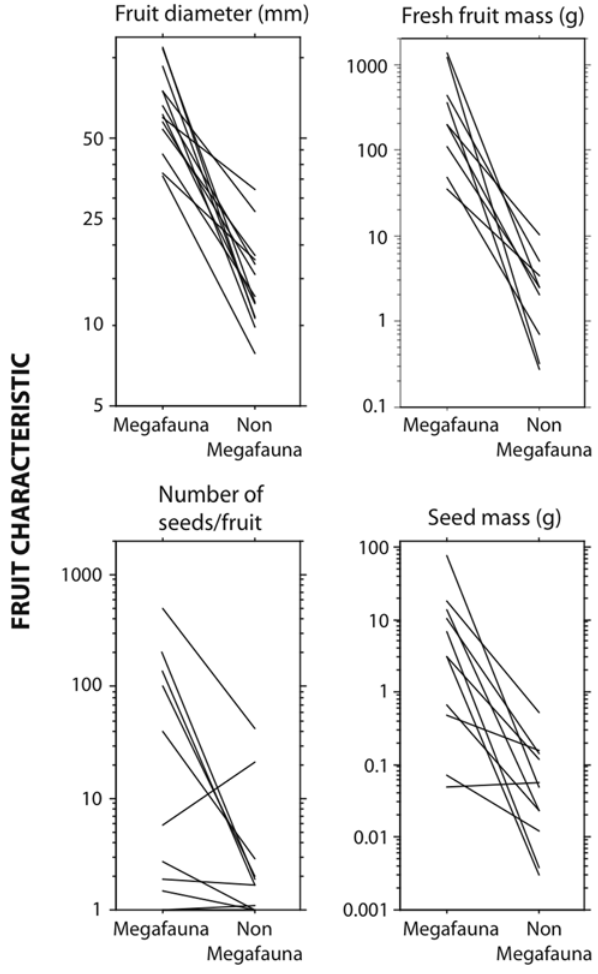
Figure 6. Within-family contrasts for fruit traits of megafauna and non-megafauna plant species. The pattern for fruit length was very similar to fruit diameter and has been omitted for clarity. Each line corresponds to the contrast (difference in mean trait value) between species of the same family with each syndrome.